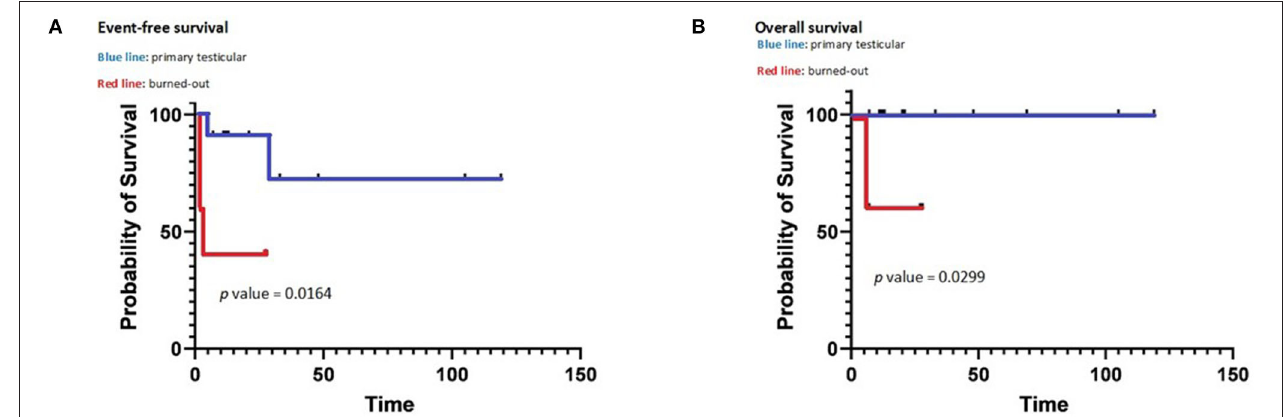
FIGURE 3 | Event-free survival (A) and overall survival (B) of primary and burned out testicular